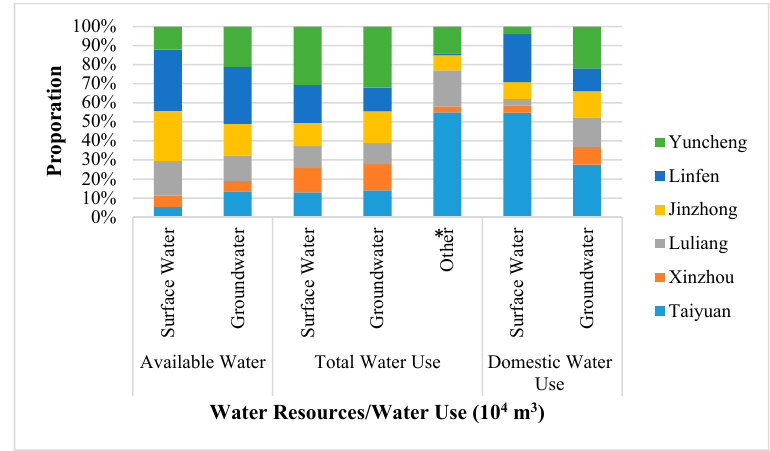
Figure 5. Available water and water usage in cities on the Fenhe River plain in 2012. (* Other represents recycled water).